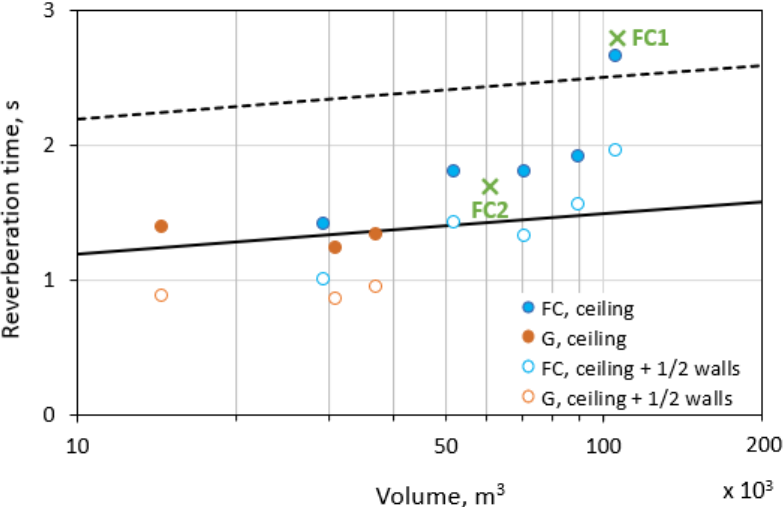
Figure 11. Estimated reverberation time T m in the studied food courts (blue points) and galleries (red points) with two types of acoustic treatment; measured reverberation time ( × ) in the food courts FC1 and FC2. The solid line is recommended reverberation time according to [34], the dotted line is 1 s higher than the solid one.